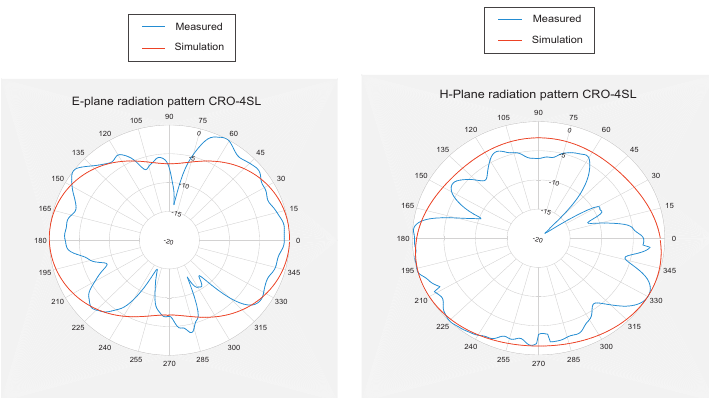
Figure 11. E-plane and H-plane H radiation patterns for the MS-IFA optimized with the CRO-4SL algorithm: ( Left ) E-plane; ( Right ) H-plane.